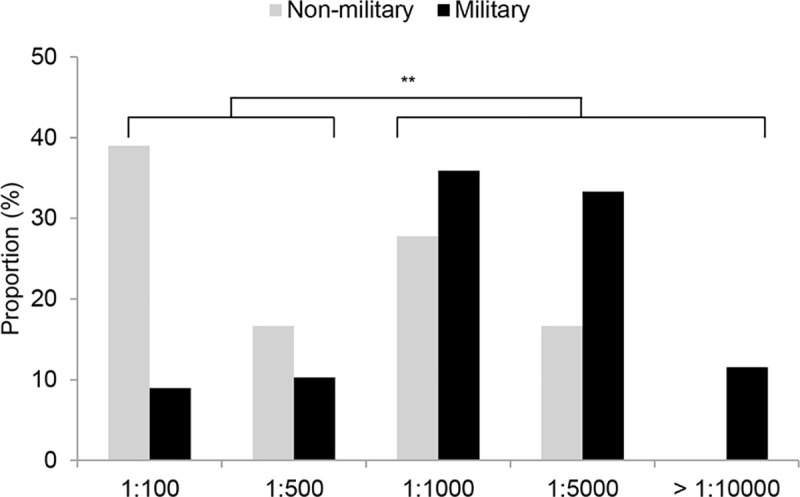
Distribution of neutralizing antibody titer against HAdV-55 according to military status.The data were analyzed with chi-square test. **P<0.01.